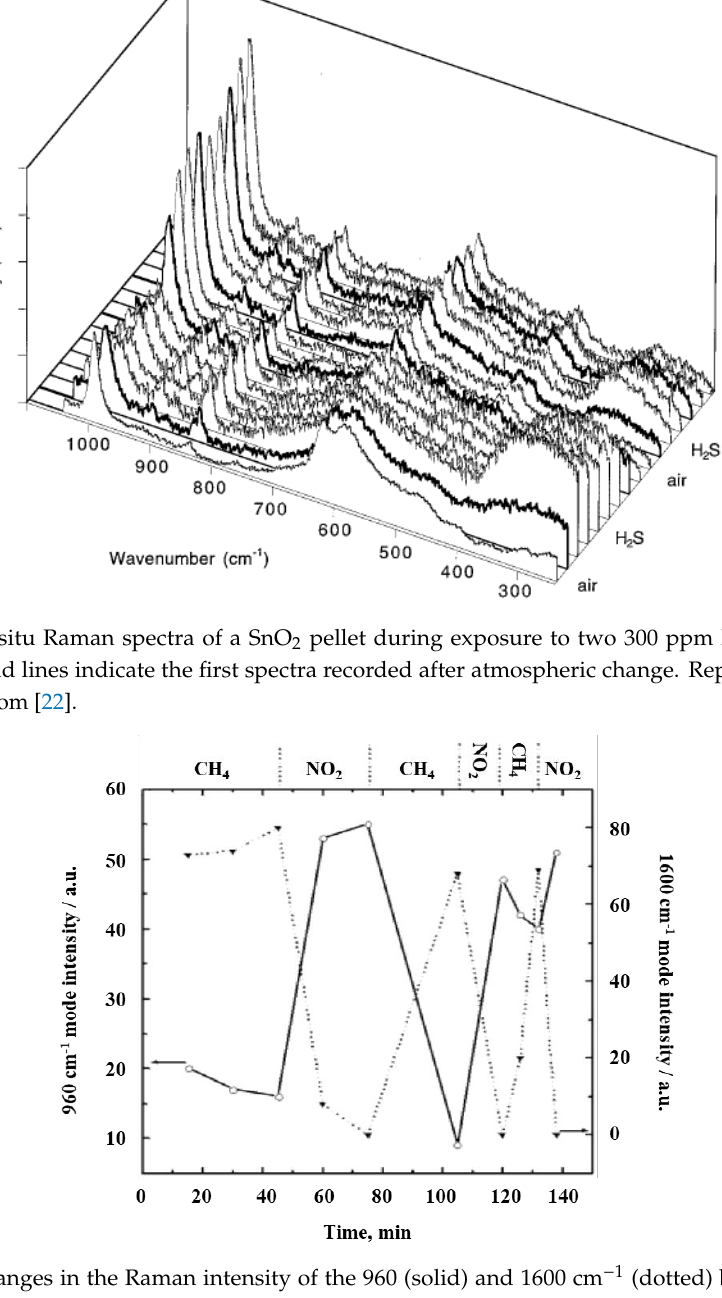
Figure 4. Changes in the Raman intensity of the 960 (solid) and 1600 cm −1 (dotted) bands of WO 3 (2 nm particle size) during varying atmospheres. Modified from [24].